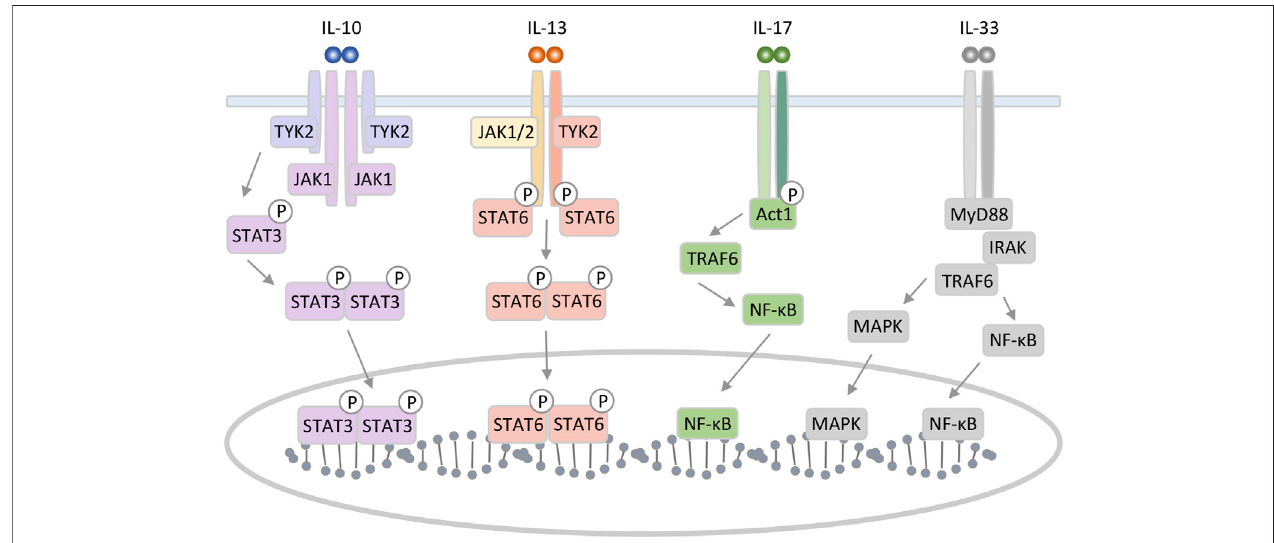
FIGURE 1 | Schematic representation of IL-10, 13, 17, and 33 interaction mechanism with their speci fi c receptors. IL-10 can form a homodimer that binds to the tetramericheterodimerIL-10receptorandinitiatesanintracellularsignalingpathway involvingSTAT3askeytranslocationnuclearfactor. IL-13bindingtotypeIIreceptor complex leadsto activation ofJAK and phosphorylation ofmembersof theSTAT family. The IL-17 receptor complex, which consists of IL-17RA and IL-17RC,activates downstream signaling pathways by recruiting an adaptor molecule named Act1. IL-33 triggers MAPK and NF- κ B leading to in fl ammatory response.